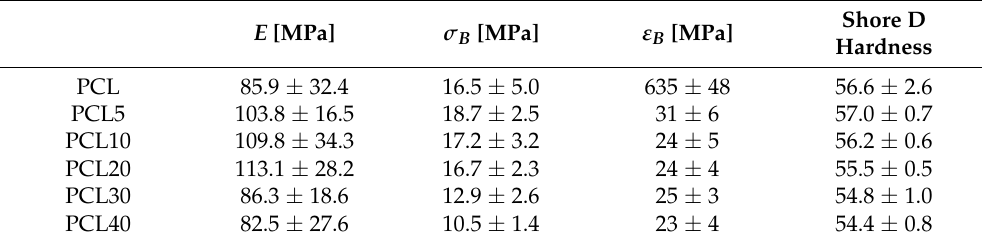
Shore D Hardness